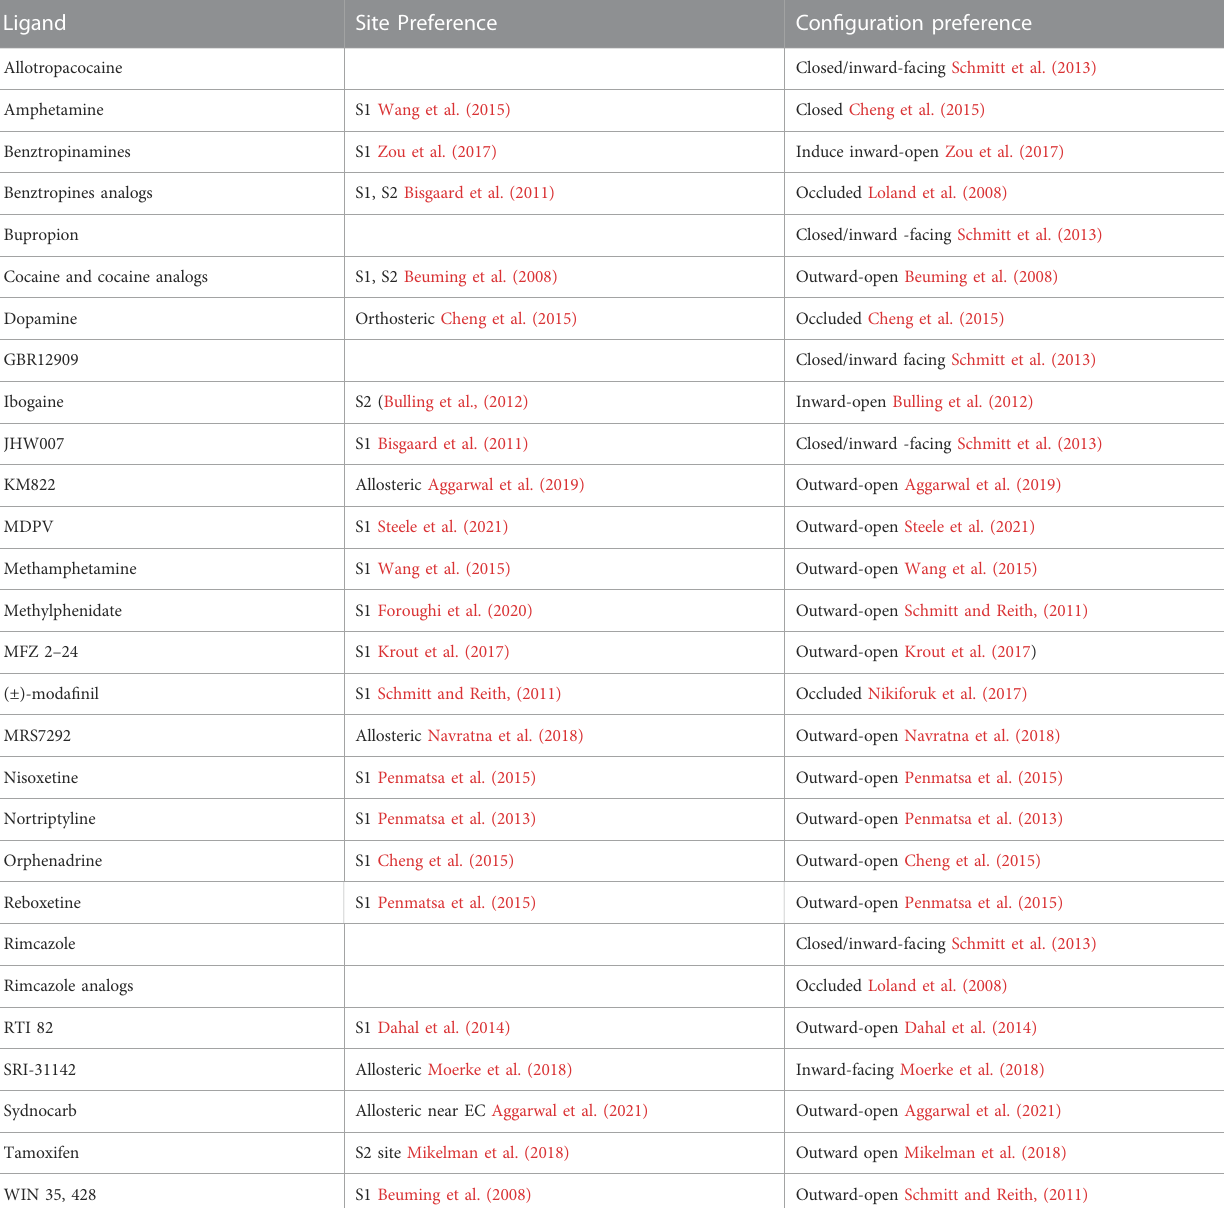
TABLE 1 List of some DAT substrates/inhibitors with their preferential binding site and DAT ’ s conformational